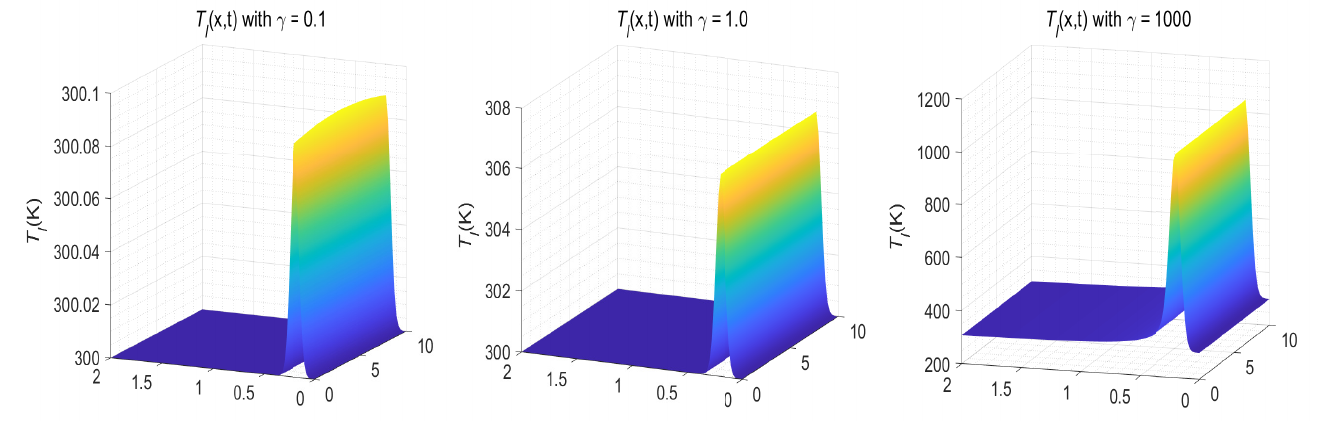
Figure 23. Temperature distributions of T l versus ( x , t ) with various γ when K n = 61.84658, ( α , β ) = ( 0.1,0.1 ) , N = 100, and M = 100 for Example 2.